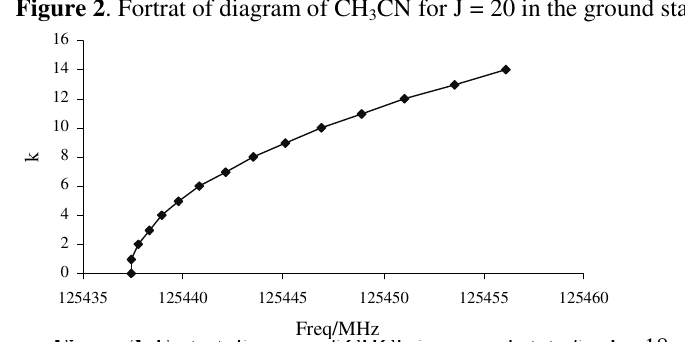
Figure 2 . Fortrat of diagram of CH